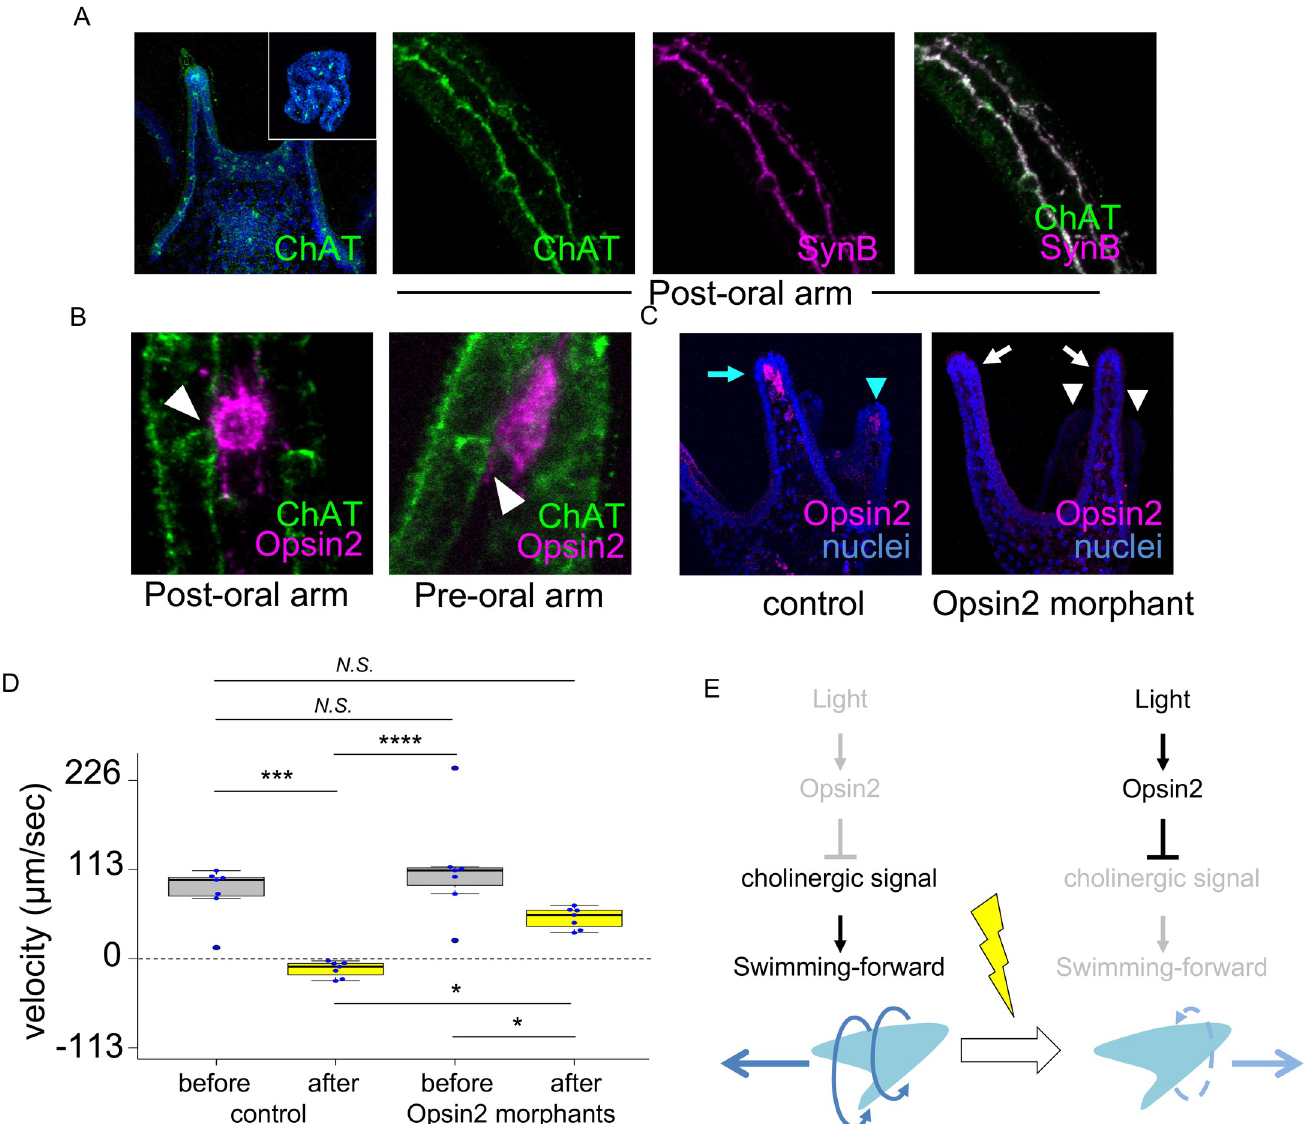
Fig 3. Opsin2, which is expressed in mesenchymal cells located in the arms, is required for photoreception. (A) Immunohistochemical analysis of the ChAT protein. The ciliary band neurons in the postoral arms are cholinergic. (inset) In situ hybridization of choline acetyltransferase ( ChAT ) mRNA in pluteus larvae. (D) The Opsin2 protein was not translated in Opsin2-MO2 morphants. (B) Details of the relationship between Opsin2-expressing cells and cholinergic neurons. The cell processes from Opsin2-expressing cells appear to attach or be closely adjacent to neurons (arrowhead). (C) The Opsin2 protein was expressed in mesenchymal cells in the postoral arms (sky-blue arrow) and preoral arms (sky-blue arrowheads), and it disappeared after morpholino injection (white arrows and arrowheads). (D) The graph shows the difference in particle velocity before vs. after photoirradiation in the presence or absence of the Opsin2 protein. The particle velocity was measured before and after photoirradiation. N = 7 in each experiment. The velocities of 10 particles were measured for each N. � , p � 0.05, �� , p � 0.01, ��� , p � 0.001, ���� , p � 0.0001, N . S ., not significant. (E) Schematic images summarizing the results of this study. Under dark or weak-light conditions (left), the cholinergic system drives forward swimming, but strong photoirradiation (right) stops the cholinergic system via